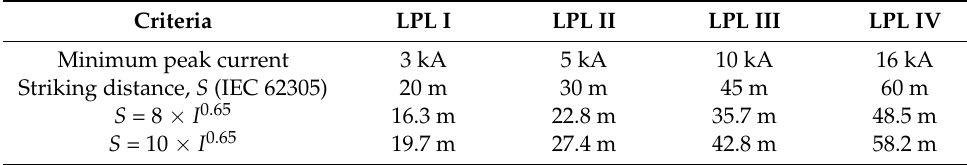
Table 3. Comparison of Striking Distance ( S ) to